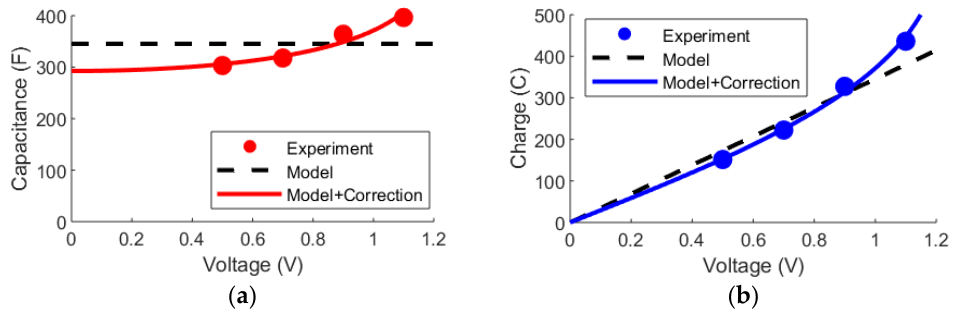
Figure 8. The data is from [70]. Dots show experimental data, while the dashed line corresponds to the basic Randles circuit and the full line corresponds to adding the charge-dependent correction factor in Equation (14) to express the capacitance. (a) The capacitance of the cell depending on the applied voltage. (b) The accumulated charge in the cell depending on the applied voltage.